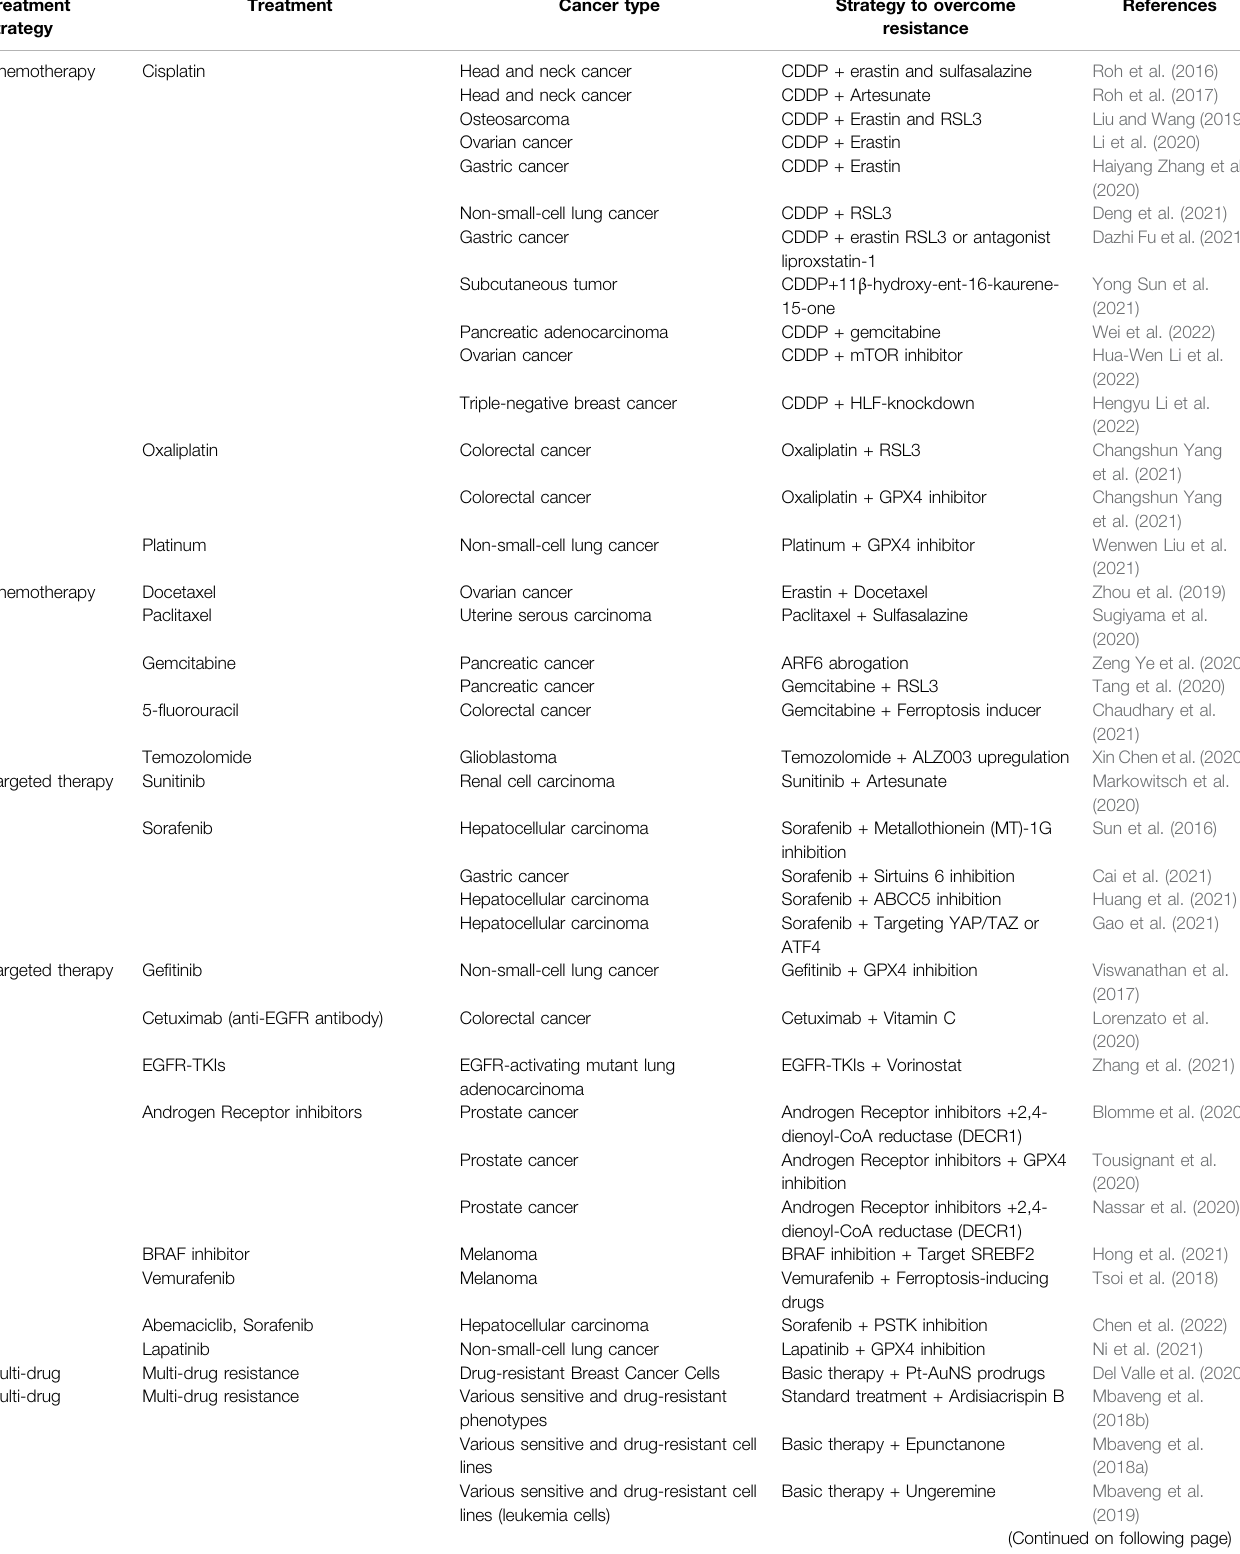
TABLE 1 | Role of ferroptosis in drug resistance and the strategy to overcome treatment resistance in